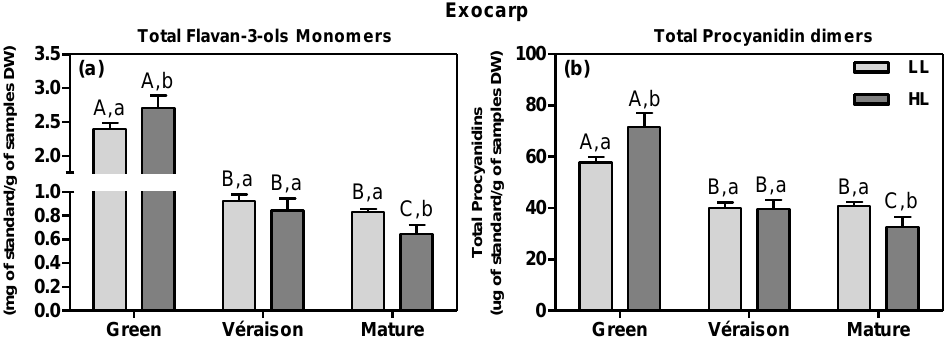
Figure 4. Total flavanols in exocarp tissue at two canopy microclimates (LL and HL; independent of mitigation treatment) and at three developmental stages (green, véraison and mature). ( a ) Total flavan-3-ols monomers levels (mg/g of dry weight (DW)): catechin, epicatechin, epicatechin-3- O -gallate. ( b ) Total procyanidin dimer levels (µg/g DW): procyanidin B1, B2 and B3. Statistical analysis with two-way ANOVA ( n = 8–12, +SD, p ≤ 0.05). Statistical notation is the same as in Figure 3.